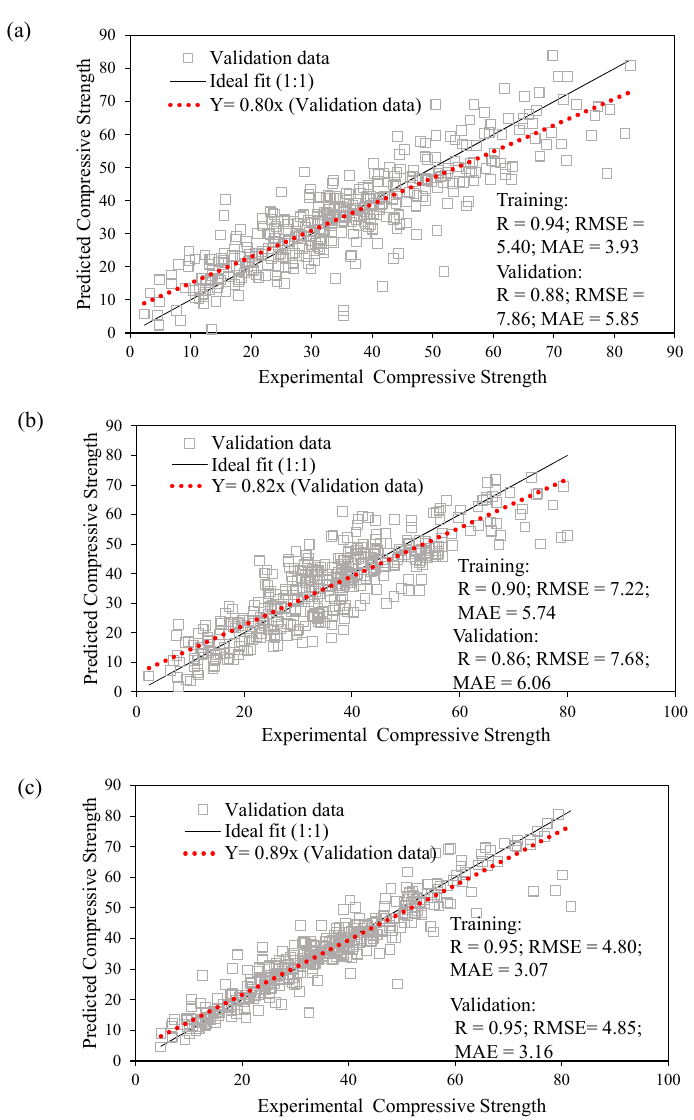
Figure 9. Comparison of experimental and predicted results: ( a ) ANFIS, ( b ) GEP, ( c ) GBT.